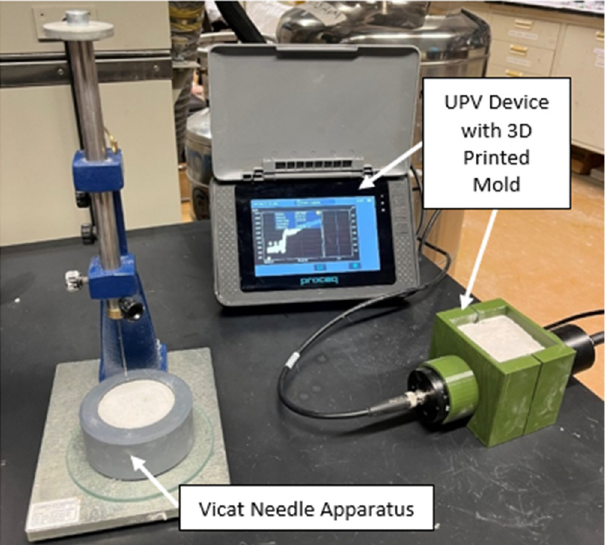
Figure 6. Experimental setup used to measure the setting